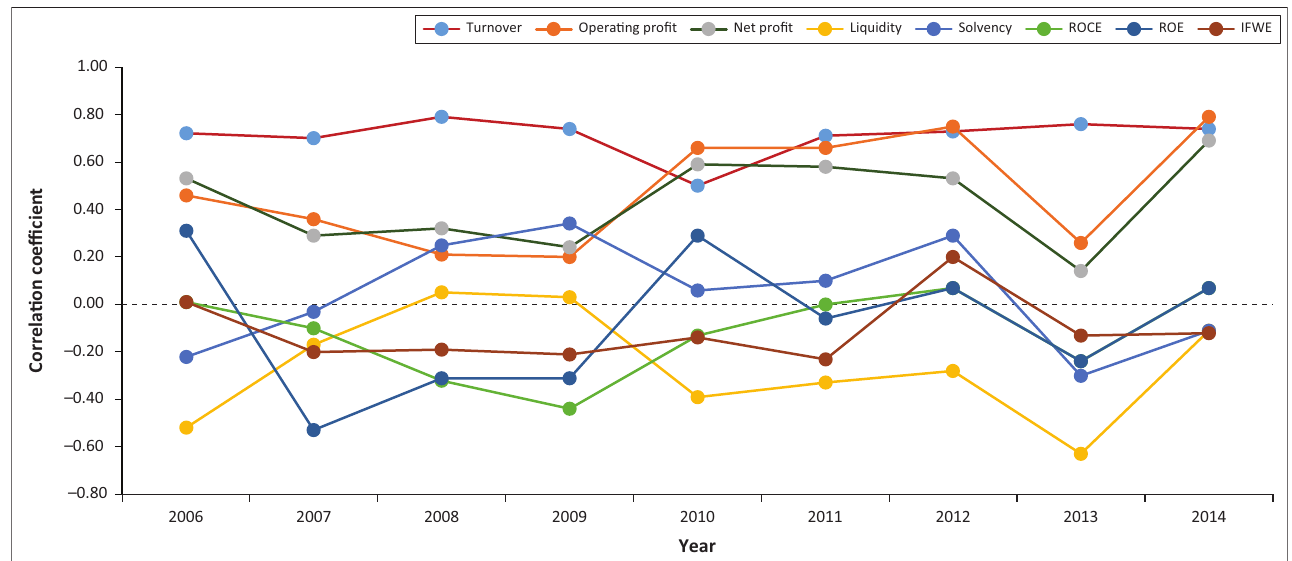
FIGURE 3: Total remuneration and state-owned companies’ performance. ROCE, return on capital employed; ROE, return on equity; IFWE, irregular, fruitless and wasteful expenditure. TABLE 6: Correlation – Chief executive officer remuneration components and audit opinion. Year Fixed pay